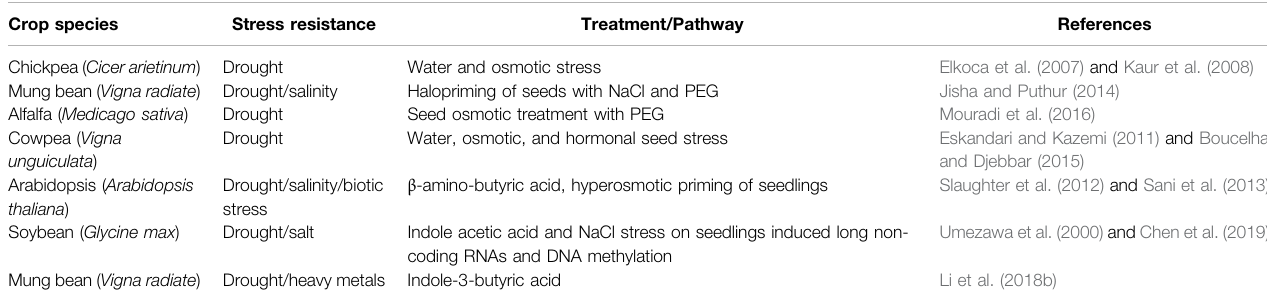
TABLE 5 | Intergenerational stress memory resistance development in crop plants through epigenetic modi fi cations. Crop